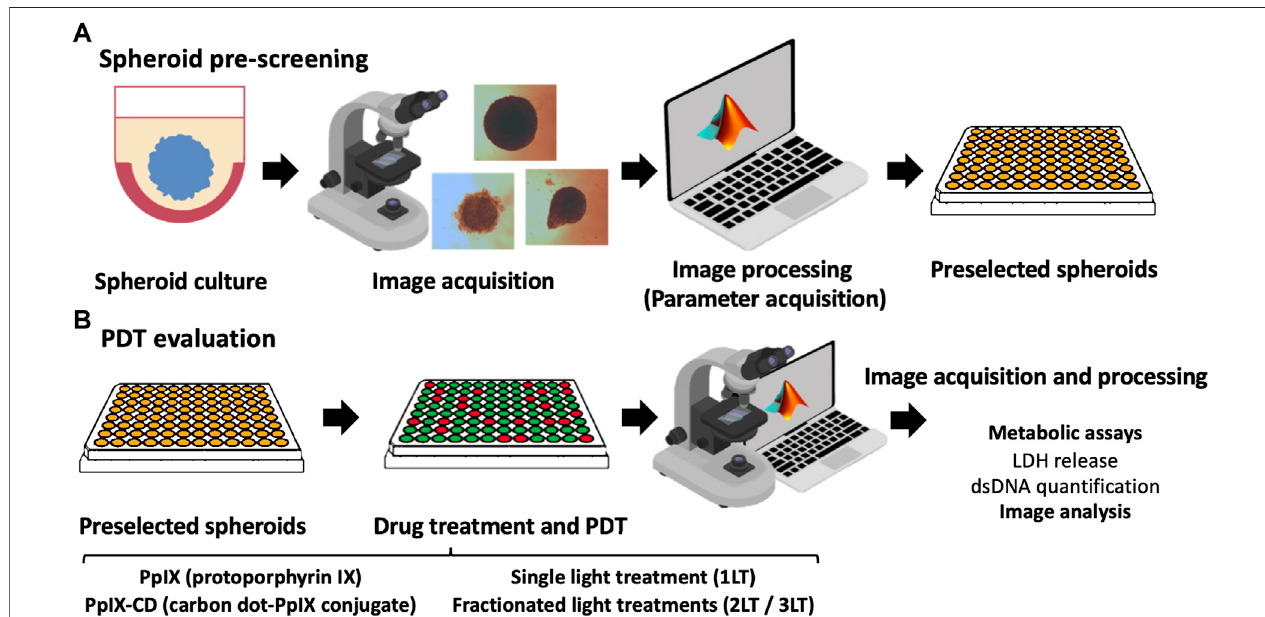
FIGURE1| SummaryofPDTparameterscreeningwork fl ow.Spheroidsareculturedusinga2-hydroxyethylagarosesurfacecoatingtopreventadhesionandleftto grow until reaching around 500 µm in diameter. Individual spheroids were monitored and pre-selected based on their morphology using the parameters of sphericity, area, and equivalent diameter (A) . Selected spheroids were then incubated with PS and subjected to PDT. Wide fi eld microscopy images were obtained after drug treatment using a 4X objective, clearing cell debris from each well to improve data acquisition. Morphometric parameters were extracted from the images and compared to results from biological assays (LDH release and total DNA content) (B) . Further information could be obtained for parameter screening, such as protein expression or advanced